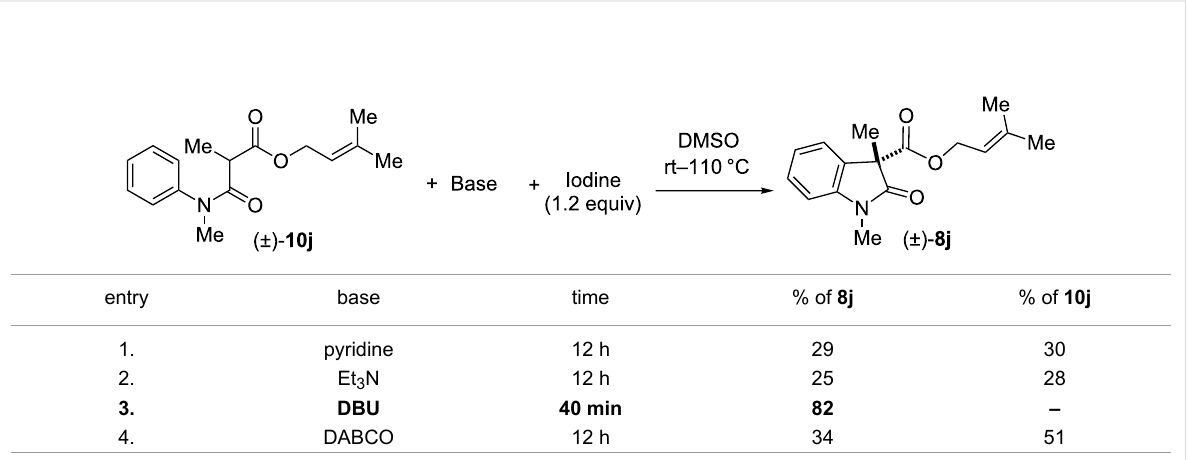
Table 2: IDC in the presence of organic bases. Reproduced from [46].